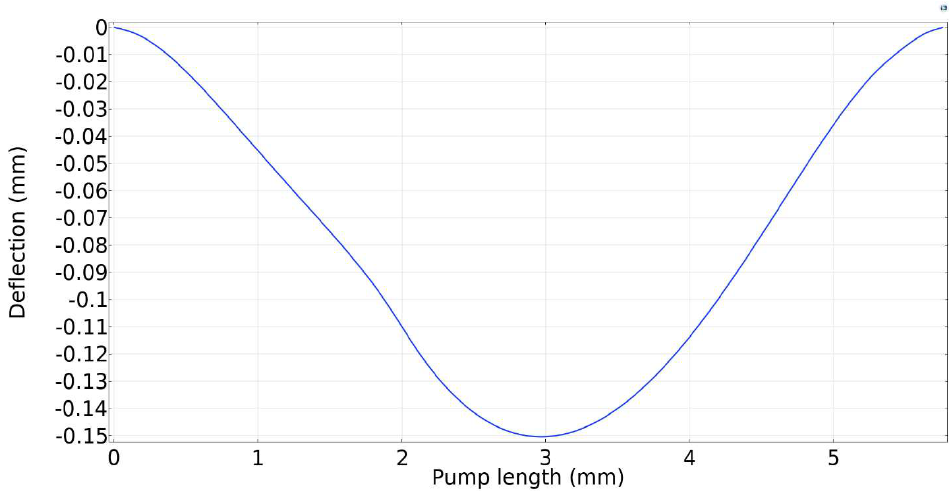
Figure 10. Deformation of upper wall across the pump length.